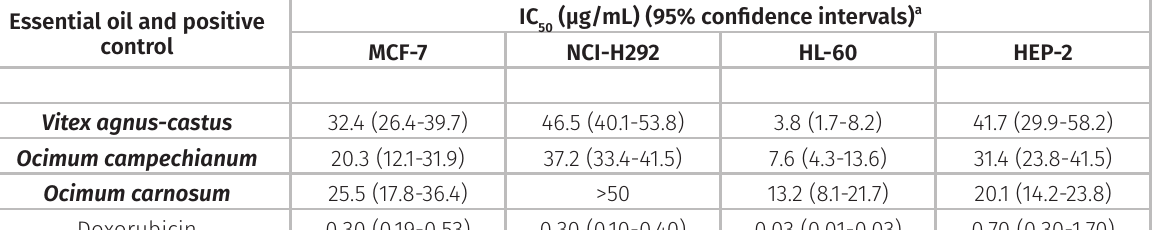
Table III. Cytotoxic activity of essential oils. Essential oil and positive